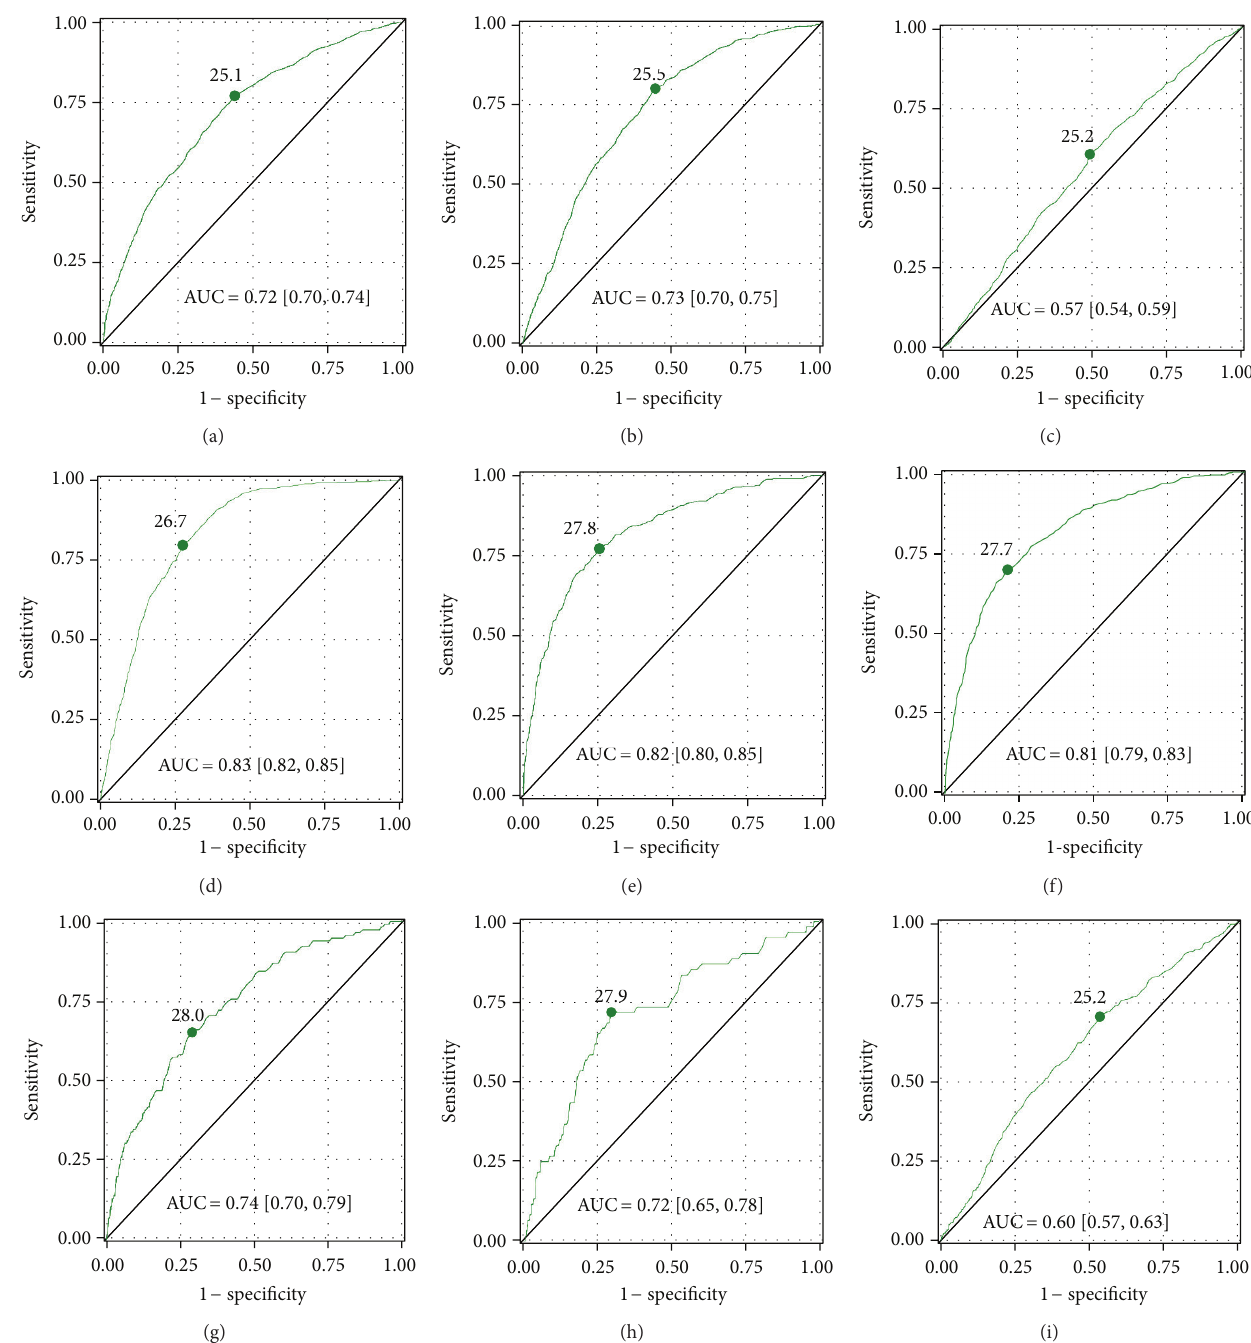
Figure 4: BMI cut-points for increased cardiometabolic risk. ROC analyses had been performed for (a) hypertension, (b) hypertriglyc- eridemia, (c) hypercholesterolemia, (d) metabolic syndrome, (e) hyperinsulinemia, (f) insulin resistance, (g) type 2 diabetes mellitus, (h) increased intima-media thickness (IMT), and (i) arteriosclerosis. Cut-points in maximal distance from the diagonal and the area under the curve [95% CI] were calculated as described in the statistical